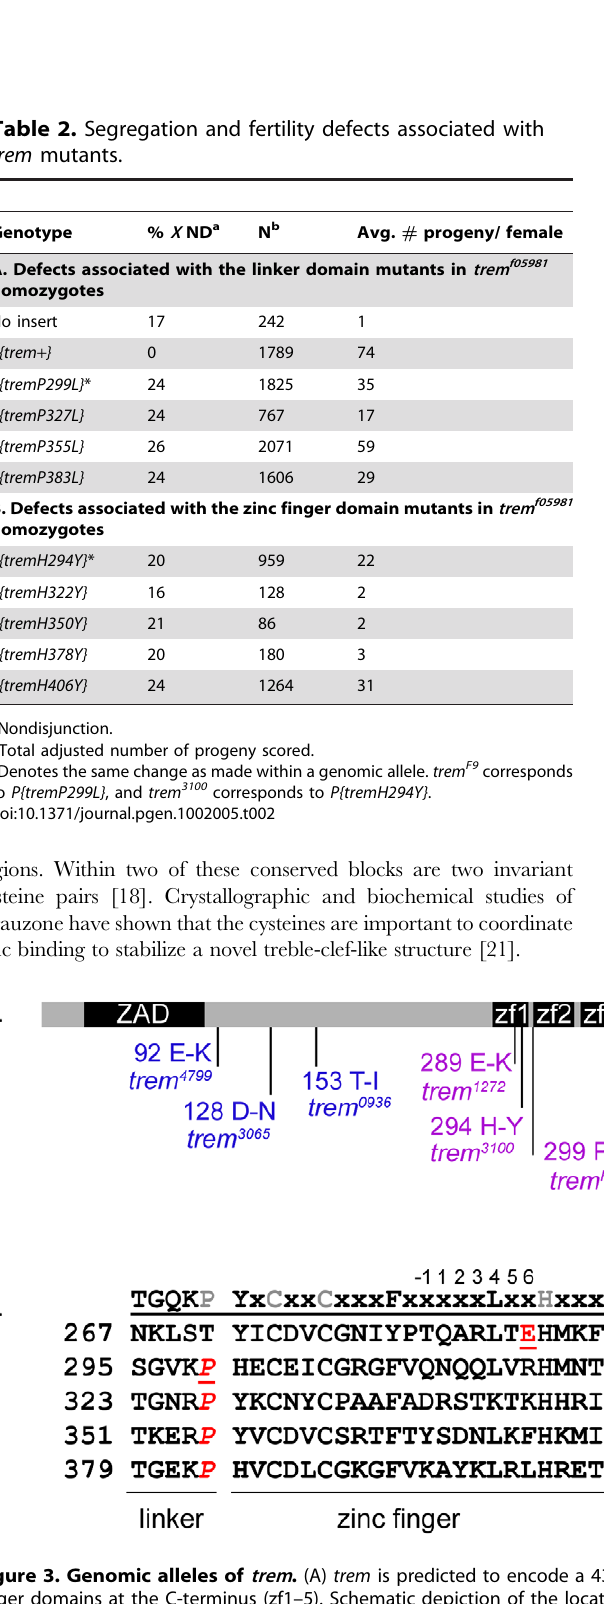
Figure 3. Genomic alleles of trem . (A) trem is predicted to encode a 439 amino acid protein that contains an N-terminal ZAD and 5 C2H2 zinc finger domains at the C-terminus (zf1–5). Schematic depiction of the location of 5 trem alleles obtained from TILLING trem and the original trem F9 allele. Meiosis defective alleles are shown in purple, and alleles that do not show a meiotic phenotype are shown in blue. (B) Sequence alignment of the 5 C2H2 zinc finger domains and linker regions of Trem. Numbers next to the sequence correspond to amino acid position. Above the Trem sequence are shown the residues typically found within C2H2-type zinc fingers and the intervals between them. The amino acid residues in grey correspond to the conserved residues within the 5 zinc fingers in Trem. The locations of the genomic trem alleles ( trem 1272 , trem 3100 and trem F9 ) are underlined, and italics denote the transgenic alleles. The amino acid residues in red correspond to fertile alleles, and those in green correspond to semi-sterile alleles. All linker domain mutations correspond to proline to leucine changes, and zinc finger mutations in the second conserved histidine correspond to a histidine to tyrosine change. The residues at position 2 1, 2, 3 and 6 are important for specifying the DNA target [26]. doi:10.1371/journal.pgen.1002005.g003 PLoS Genetics |